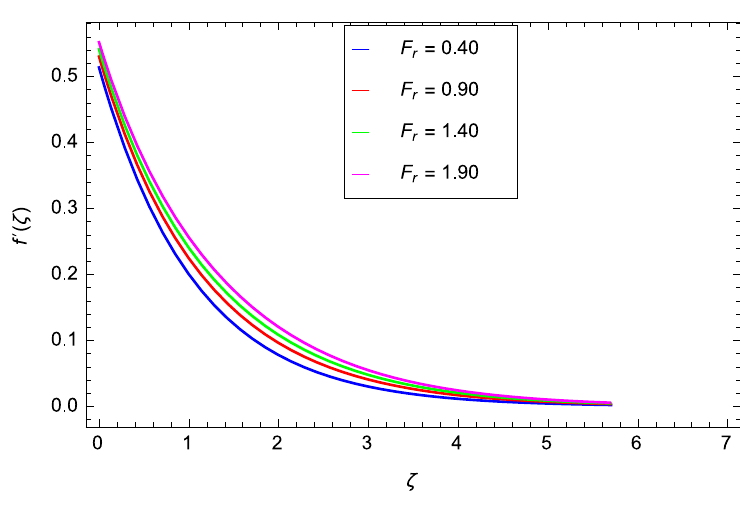
Figure 3. Influence of Fr on f (cid:48) ( ζ ) .